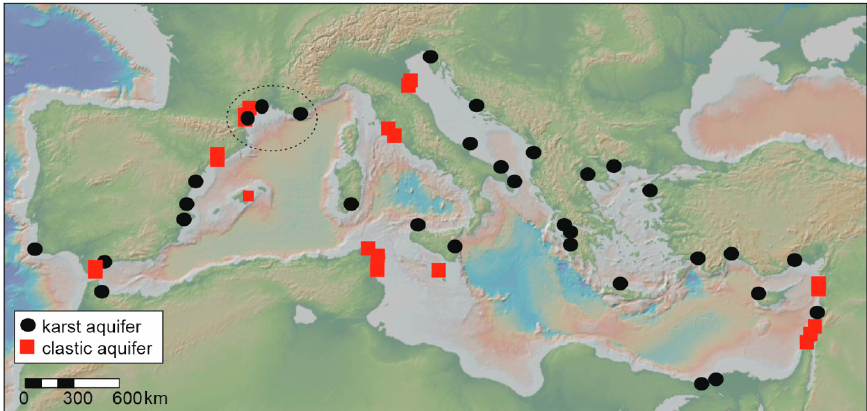
Figure 11. The main Mediterranean coastal aquifers which are affected by groundwater quality degradation due to seawater intrusion and anthropogenic contamination [2] Compiled from References [2,130,131]. The back dashed ellipse highlights the area of the case studies presented in this review, located in Southern France.